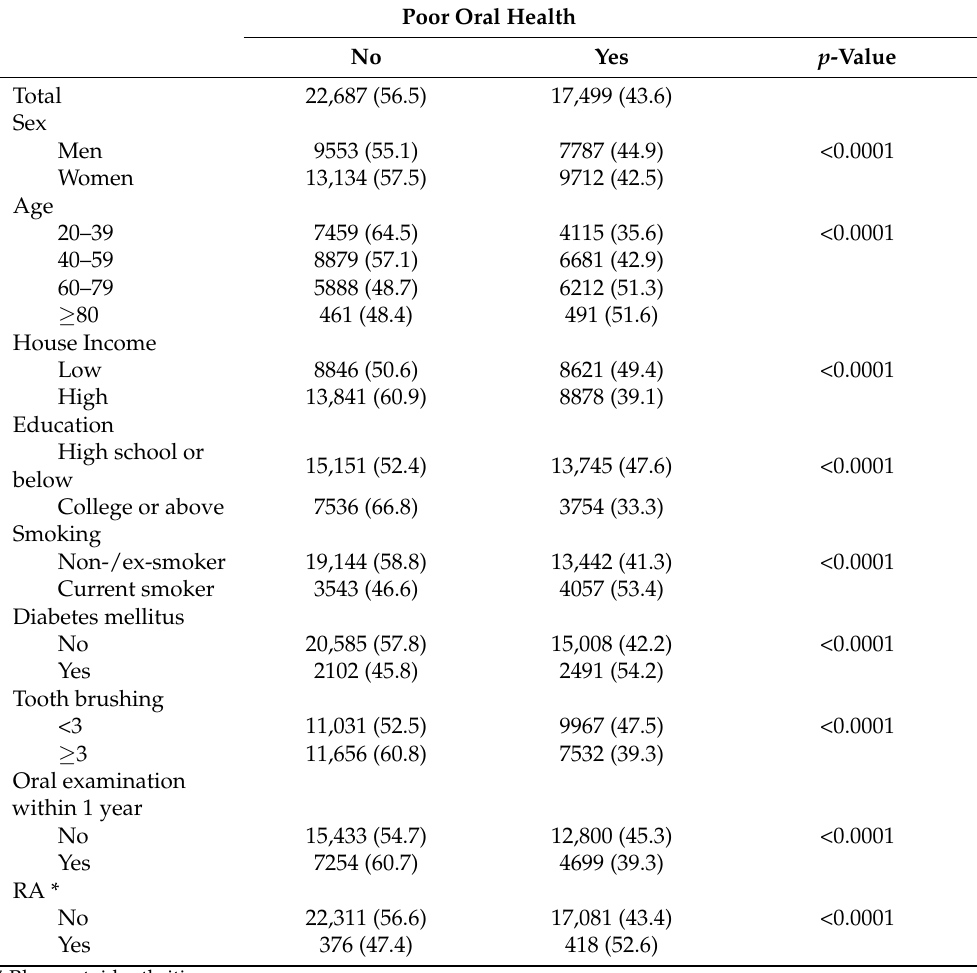
Table 1. Characteristics of participants according to poor oral